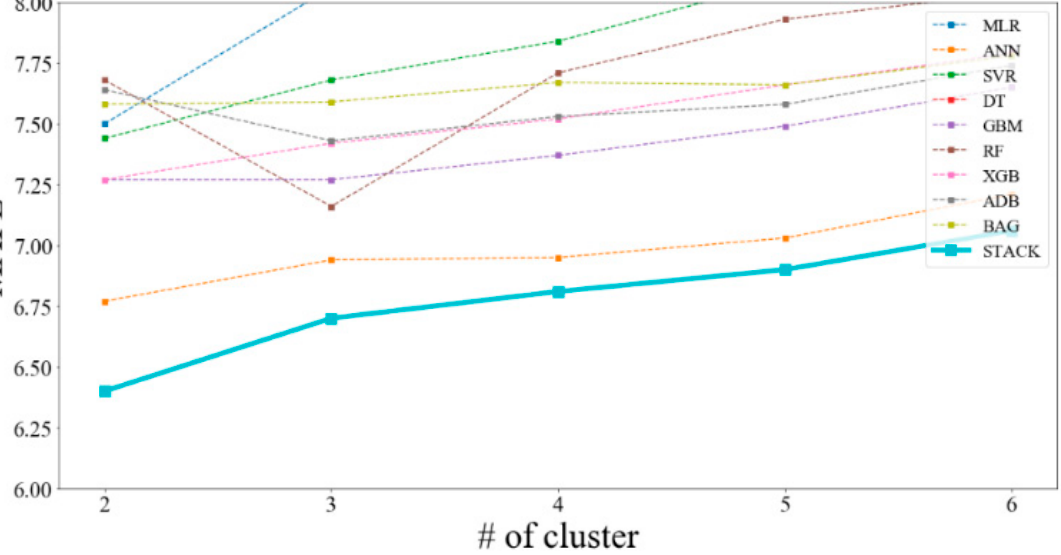
Figure 7. MAPE for each model according to the number of clusters. Appl. Sci. 2019 , 9 , x FOR PEER REVIEW